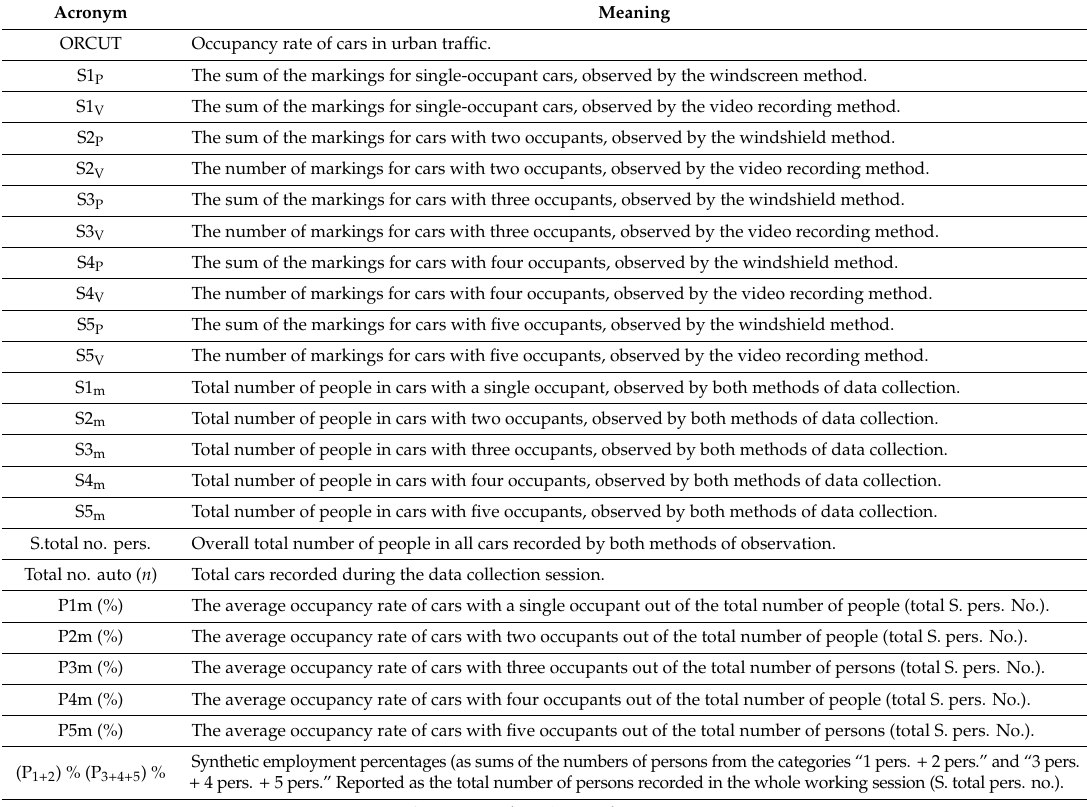
Table 1. The meanings of the acronyms used to record the data.